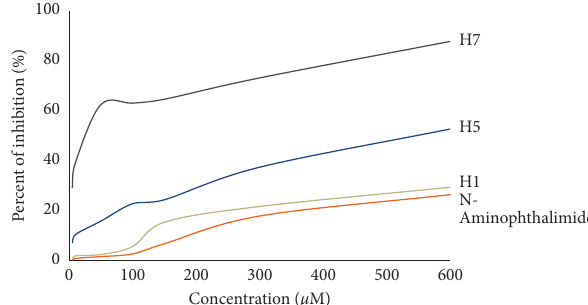
Figure 3: DPPH free radical inhibition percentage of selected active imines compounds and the starting material N-